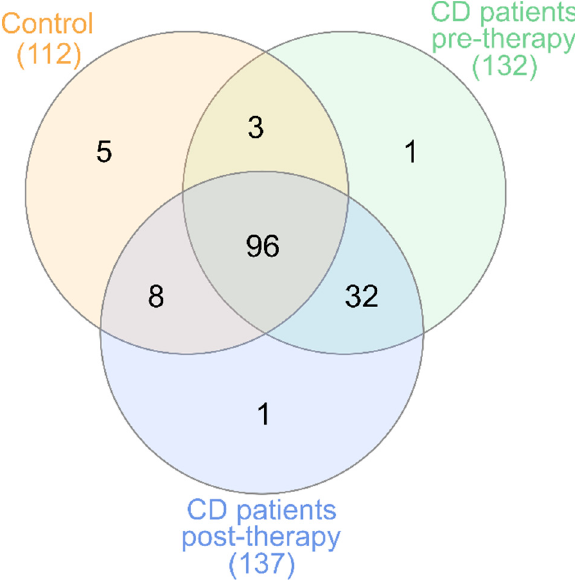
Figure 4. Analysis of species (L7) overlaps between different groups. Taxonomy was assigned with a 99% similarity with the Greengenes 13.8 database. Additional information about overlaps is presented in Supplement Materials 4 and 5.